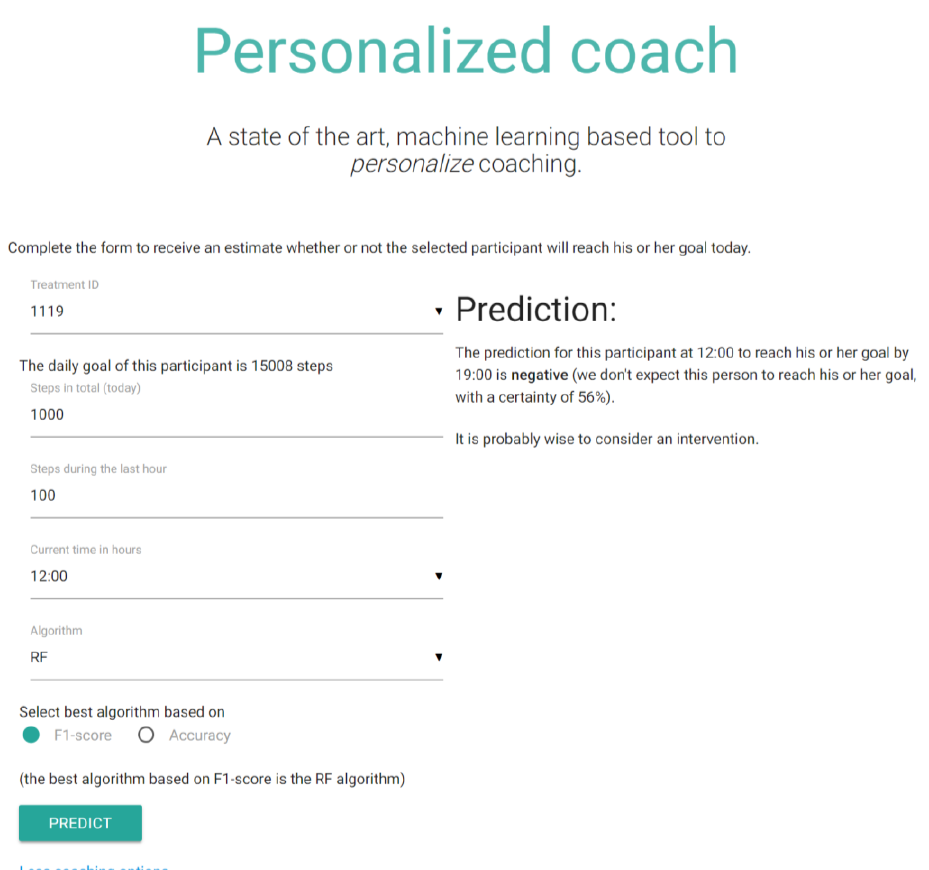
Figure 6. Screenshot of the Personalized Coach Web Application.